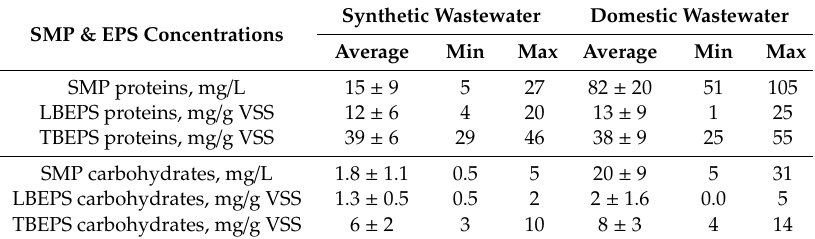
Table 3. Soluble microbial products (SMP) and extracellular polymeric substances (EPS) comparison in synthetic and domestic wastewater.